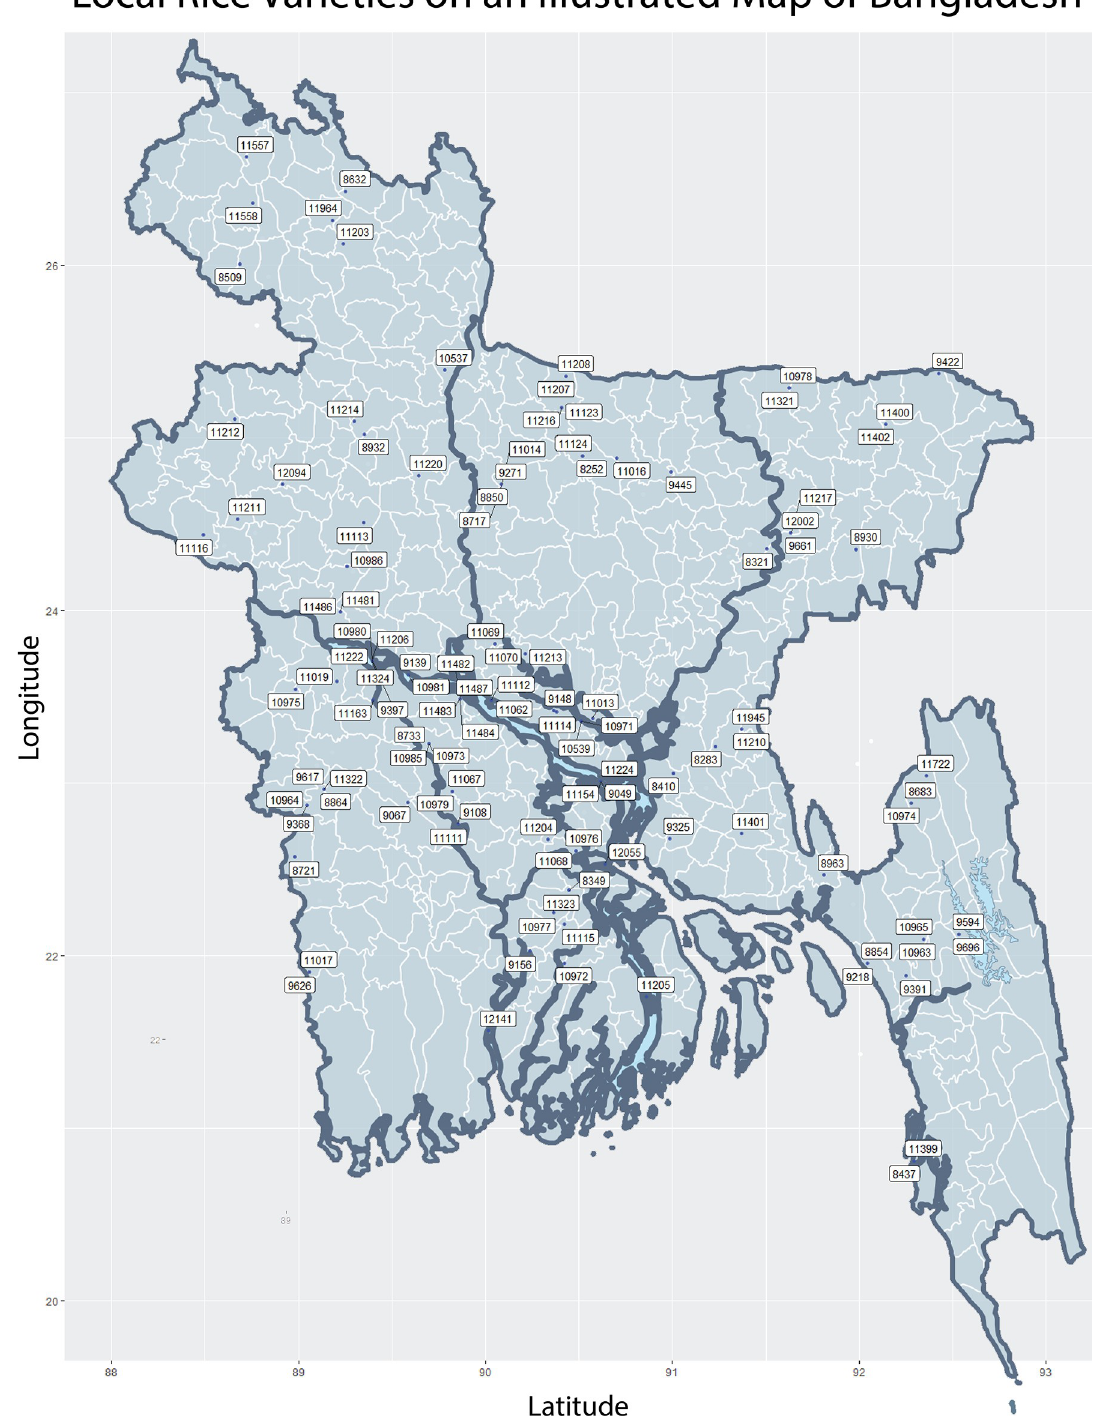
Fig 1. Map of Bangladesh showing the locations where 114 out of 176 rice varieties from this study have been traditionally propagated and cultivated. The labels in the image are the IRIS codes from S1 Table lacking the common ‘IRIS_313-’ prefix.